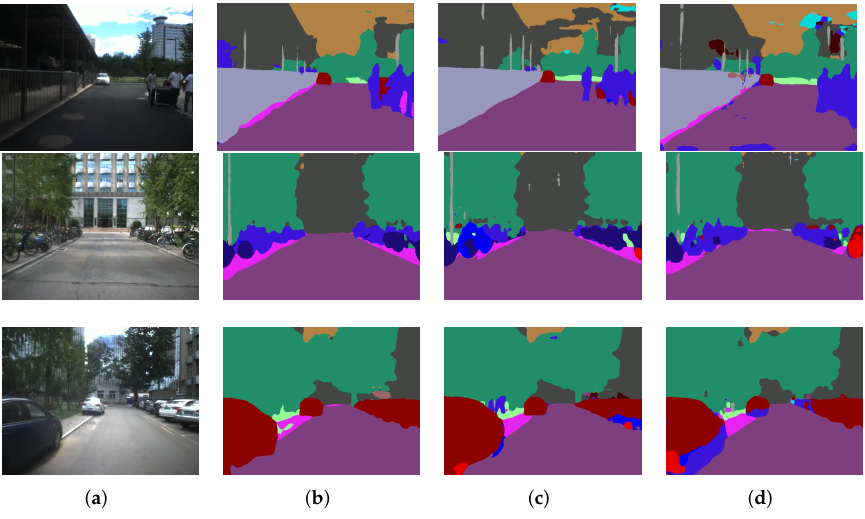
Figure 7. Semantic segmentation results in the real-world environment using the six wheel-legged mobile robot. ( a ) Original images. ( b ) EDBNet (proposed). ( c ) DABNet. ( d )